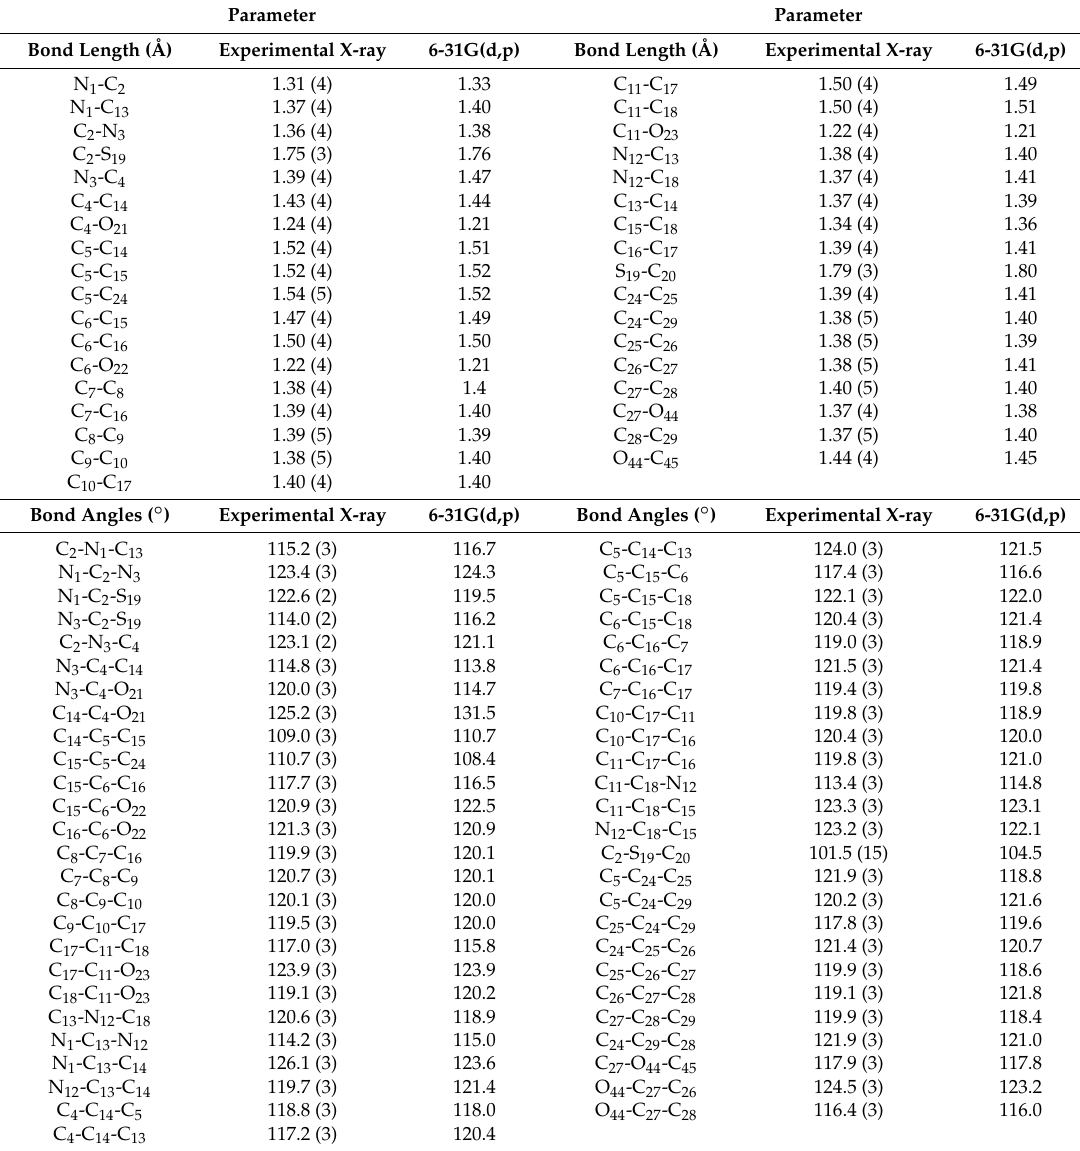
Table 3. X-ray experimental analysis data and lengths, angles and dihedral angles bonds of 4c calculated by Density functional theory (DFT)